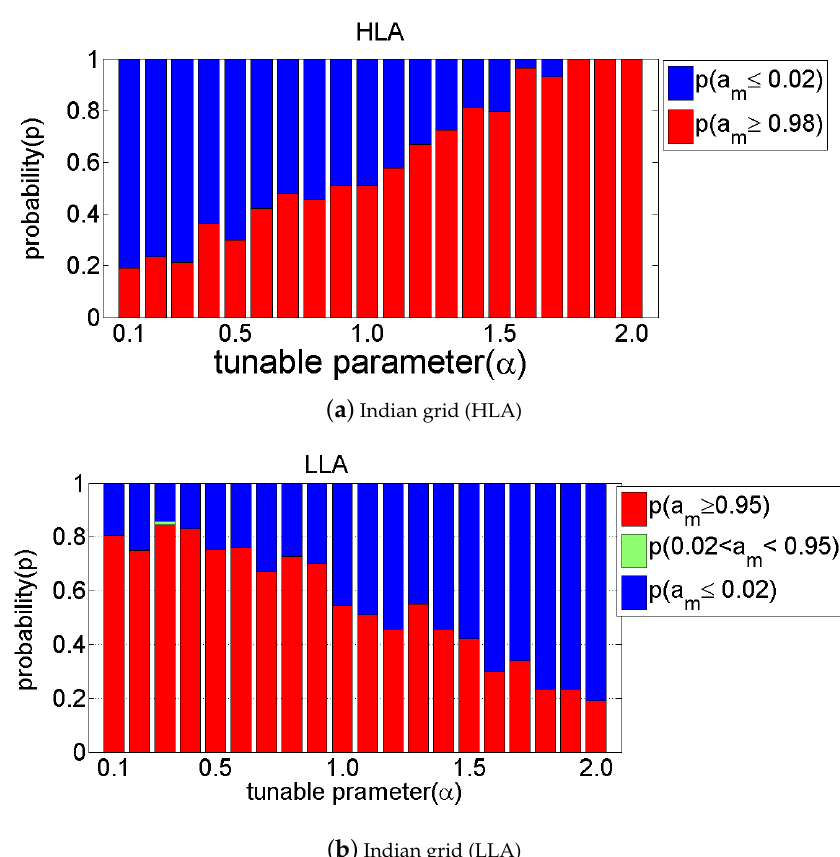
Figure 5. Probabilities of cascading failures in the Indian power grid under HLA and